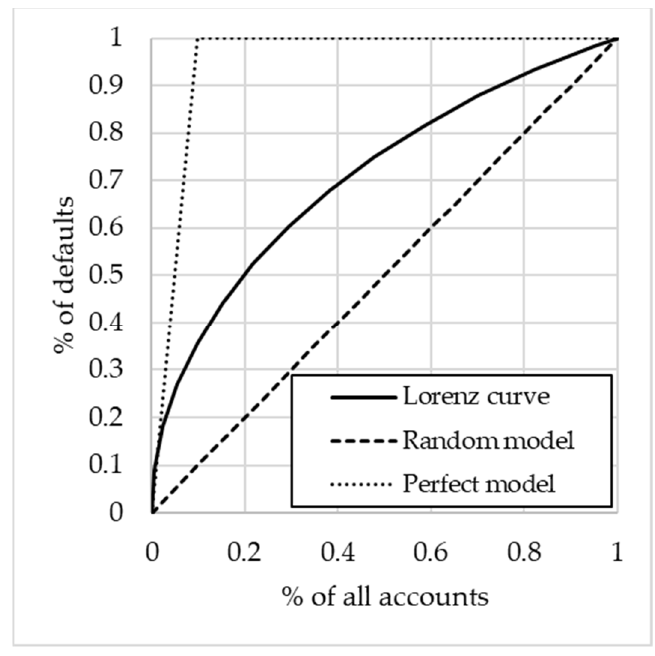
Figure 1 . Lorenz curve example. Figure 1. Lorenz curve